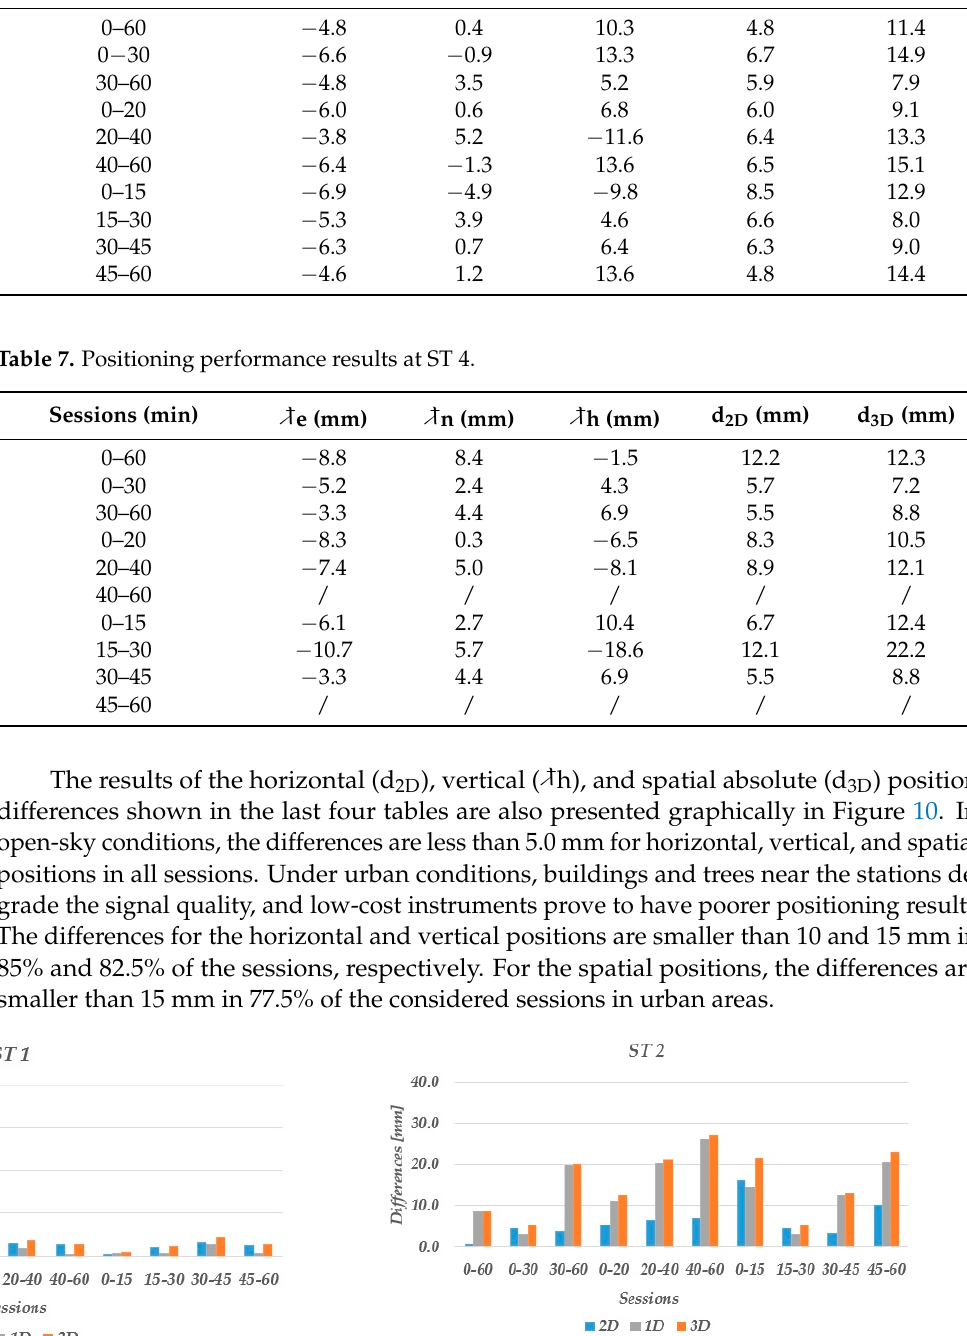
Table 6. Positioning performance results at ST 3.